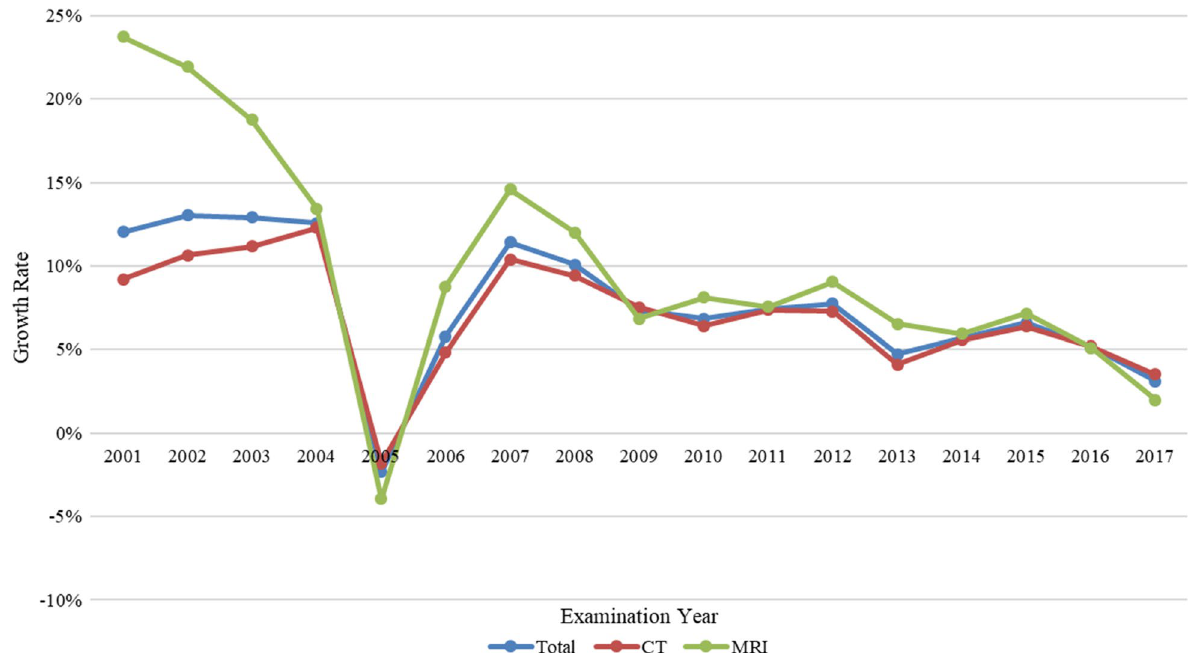
Fig. 2 The growth rate of medical imaging utilization in Taiwan from 2000 to